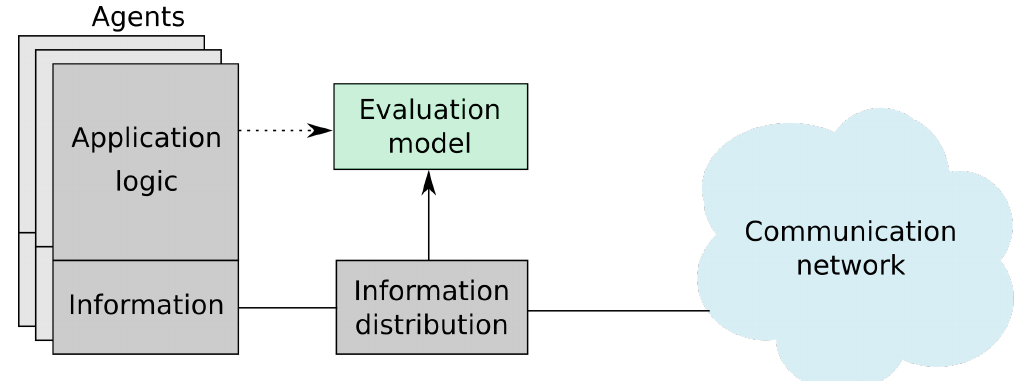
Figure 1. The proposed model aims at abstracting the mission from communication in order to evaluate information